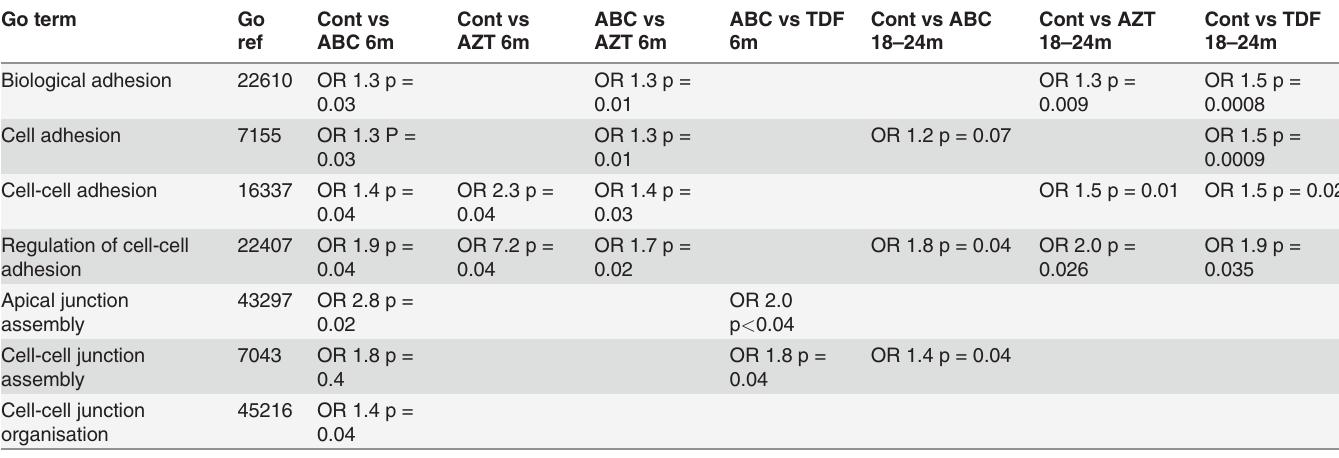
Table 6. Selected GO terms relating to cell